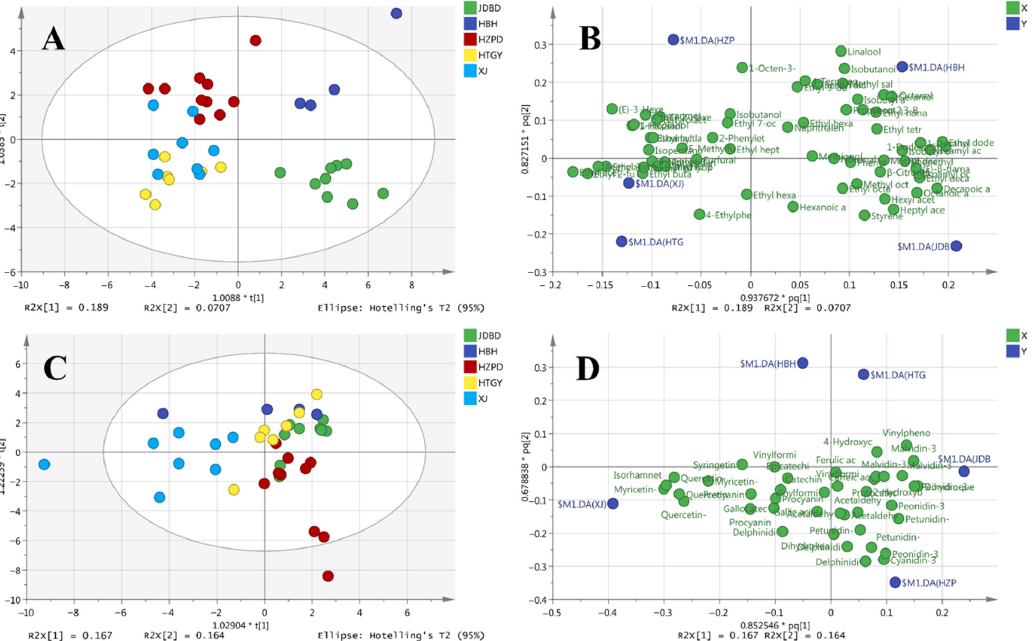
Figure 2. OPLS-DA models based on the flavor compounds of Marselan wine samples from different regions of China. ( A ) Score scatter plot for Marselan wine samples based on the concentrations of volatile compounds. ( B ) Loading plot for the volatile compounds of Marselan wine samples. ( C ) Score plot for Marselan wine samples based on the concentrations of phenolic compounds. ( D ) Loading plot for the phenolic compounds of Marselan wine samples.